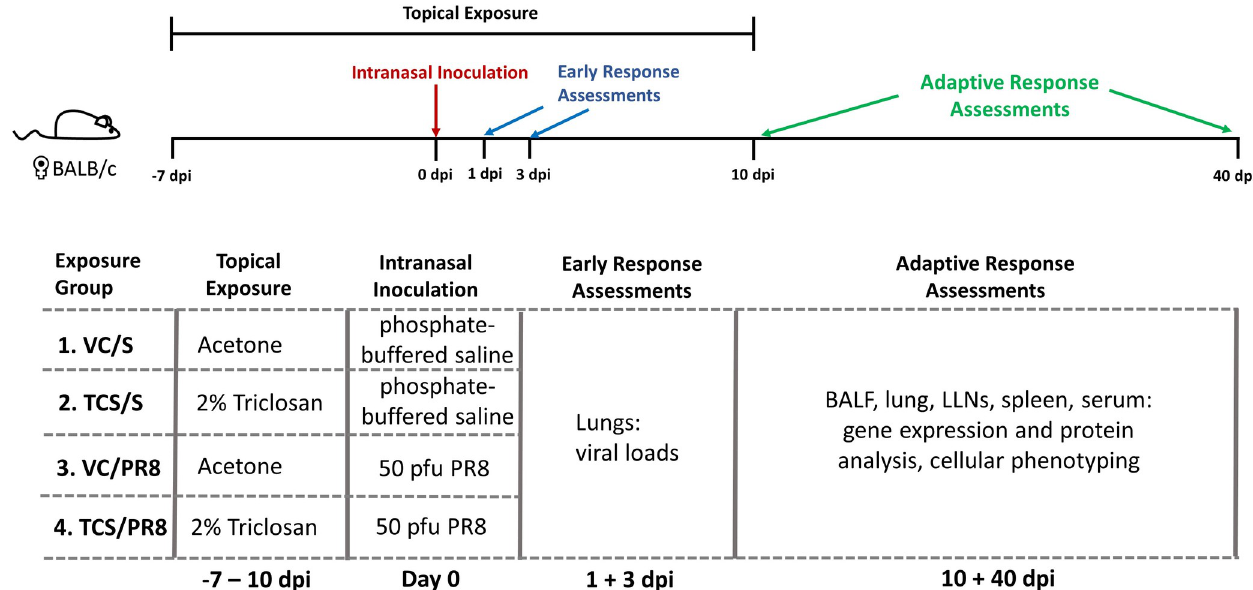
Fig 1. Diagram of experimental scheme. BALB/c mice were dermally dosed with acetone or 2% TCS on the dorsal surface of the ear (25 μ l/ear) starting at day -7 and continuing through 10 days post infection (dpi). On Day 0, mice were intranasally inoculated with 50 pfu of Influenza A virus PR8 (PR8) diluted in saline or mock infected with saline in a 50 μ l volume. Mice were sacrificed on days 1 and 3 post infection to assess viral titers and at days 10 and 40 post infection to assess adaptive immune responses as noted. Exposure groups contained 5 mice/group per timepoint.